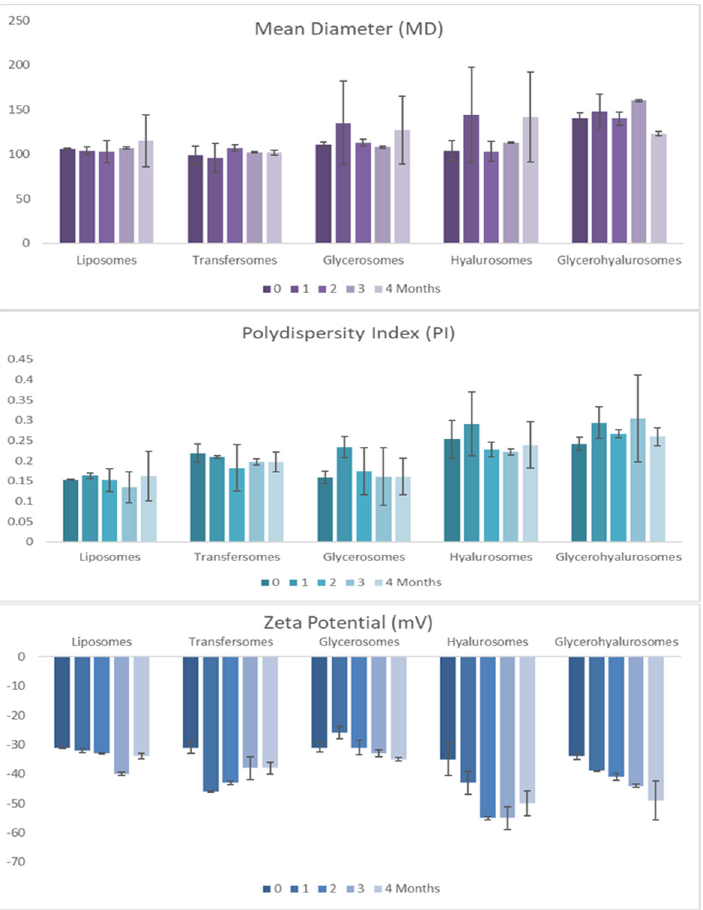
Figure 3. Mean diameter (MD), polydispersity index (PI) and zeta potential (ZP) of vesicles loading T. marum extract over 120 days of storage.